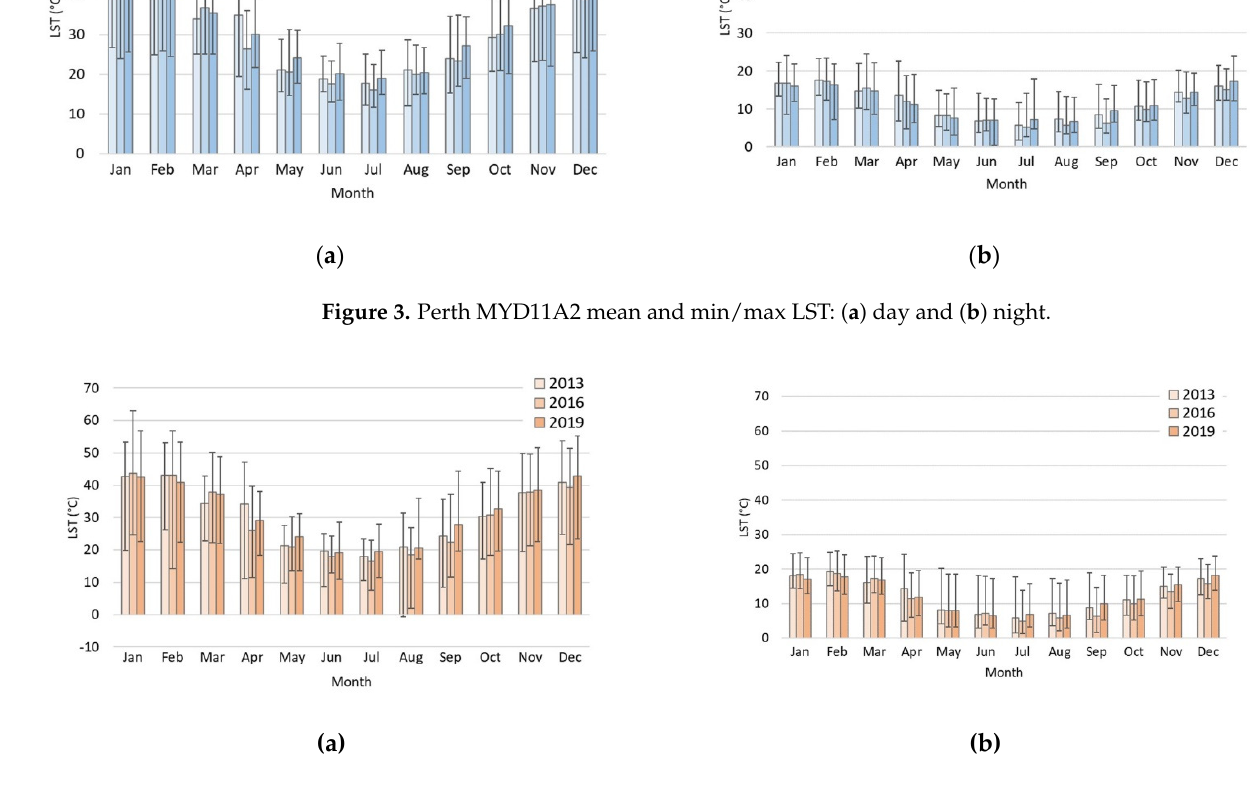
Figure 4. Perth VNP21A2 mean and min/max LST: ( a ) day and ( b ) night.